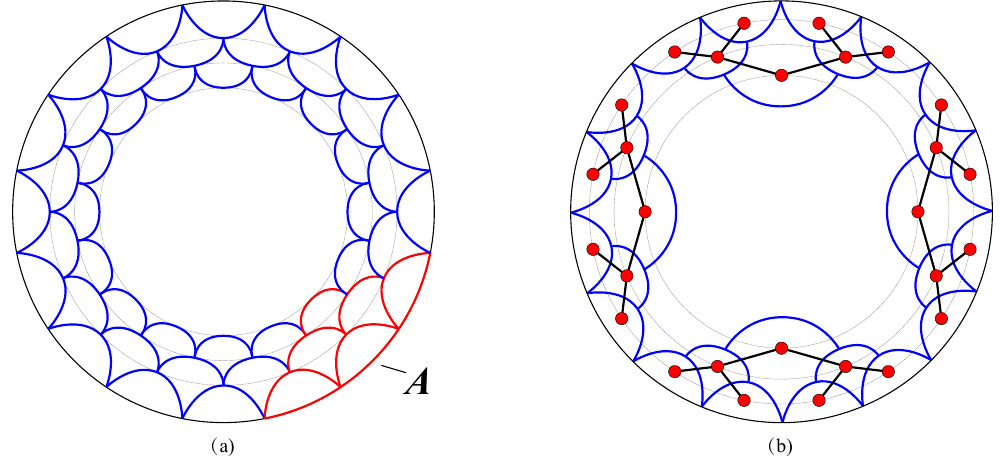
Figure 1 . (a) A surface growth picture for AdS 3 , each two adjacent RT surfaces can generate a new minimal surface of the next layer, and so on. Note that a boundary subregion A composed of n pieces, can only grow n − 1 new small surfaces in the second layer, and so on, therefore the entire A region is expected to grow only as deep as n layers in the bulk. (b) From another point of view, each component unit can be considered as a tensor. Furthermore, if we choose the surface growth picture appropriately, the resulting tensor network seems to correspond to the MERA-like tensor